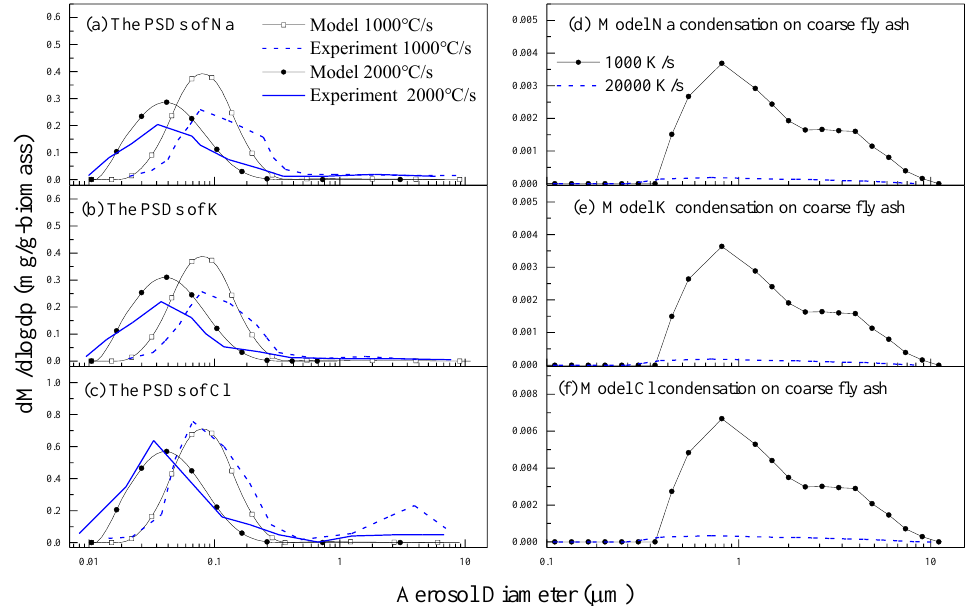
Figure 5. When the cooling rate is 1000 and 2000 °C/s, the calculated mass PSDs of inorganic ele- ments in PM 10 are compared with the measurements and the calculated condensation amount of the elements on coarse fly ash particles at the biomass feeding rate of 0.25 g/min, where ( a – c ) are PSDs of PM 10 . ( d – f ) Condensation of elements on fly ash particles. Figure 4d–f show the heterogeneous condensation of elements Na, K, and Cl in the particle size range of 1-10 μm. As can be seen, with the increase of the cooling rate, the